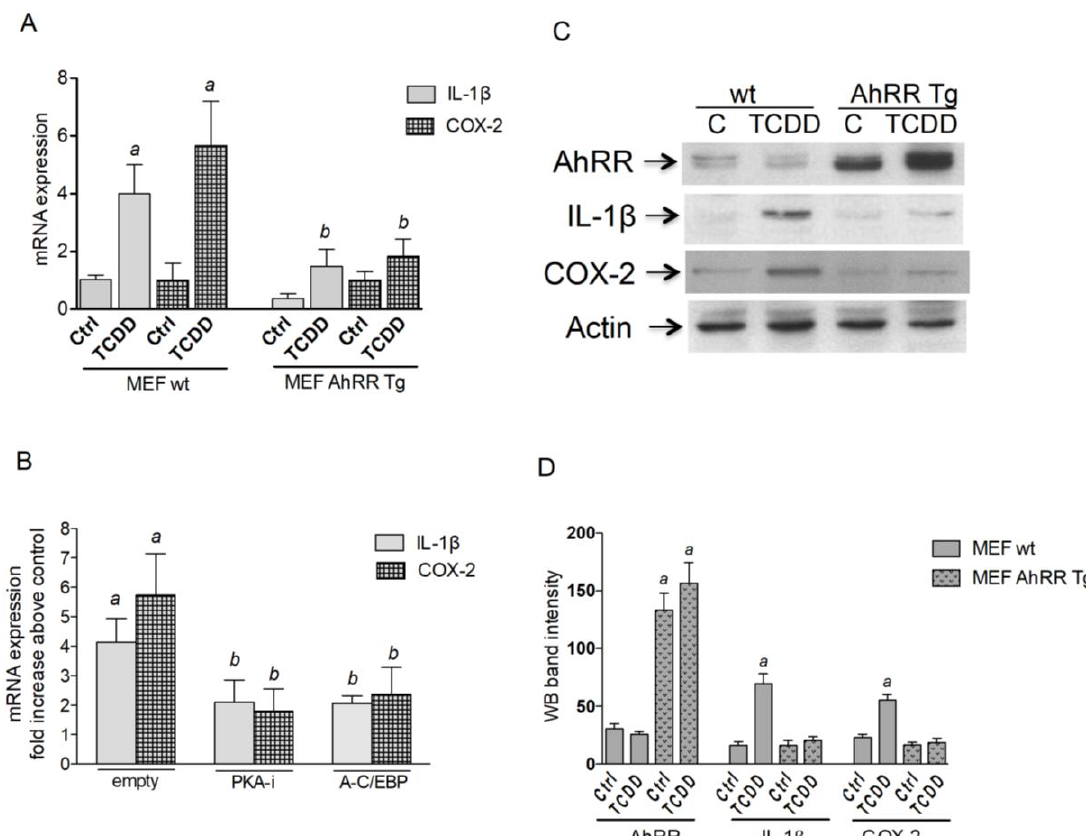
Figure 3. AhRR suppresses TCDD-induced expression of COX-2 and IL-1 β in MEF. ( A ) MEF from wt and AhRR Tg mice were treated with 1 nM TCDD for 24 h and mRNA expression of COX-2 and IL-1 β was analyzed by qPCR. a significantly higher than Ctrl; b significantly lower than wt, p < 0.05. ( B ) TCDD-induced expression of COX-2 and IL-1 β is PKA and C / EBP dependent. MEF wt were transfected with an empty vector as control and dominant negative expression vectors PKA-i or A-C / EBP. After 16 h transfection MEF wt were treated with 1 nM TCDD for 24 h and mRNA expression was analyzed by qPCR. a significantly higher than Ctrl; b significantly lower than wt, p < 0.05. ( C ) Repressed protein level of IL-1 β and COX-2 in AhRR Tg MEF determined by Western blot. MEF derived from wt or AhRR Tg mice were treated for 24 h with 1 nM TCDD or vehicle (0.1% DMSO). ( D ) densitometric evaluation of band intensities of the western blot bands of MEF wt (open bars) and MEF AhRR Tg (shaded bars) is presented. Results of three separate experiments are shown as mean values ± S.D. a significantly di ff erent from control cells ( p < 0.05).